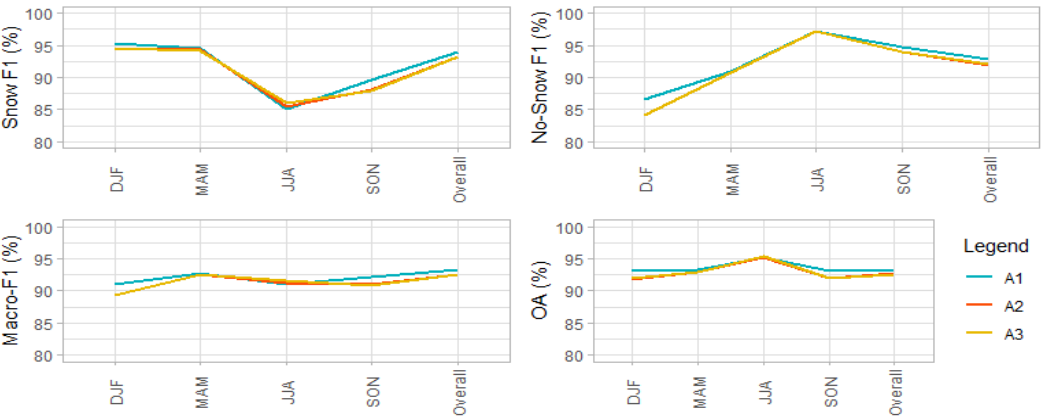
Figure 5. Accuracy metrics for Snow and No-Snow classes of the classification’s performances against an independent dataset of S2 scenes. F1 = F1-score, OA = Overall Accuracy, DJF = December-January-February, MAM = March-April-May, JJA = June-July-August, SON = September-October-November. A1 = blue line, A2 = red line, A3 = yellow line.